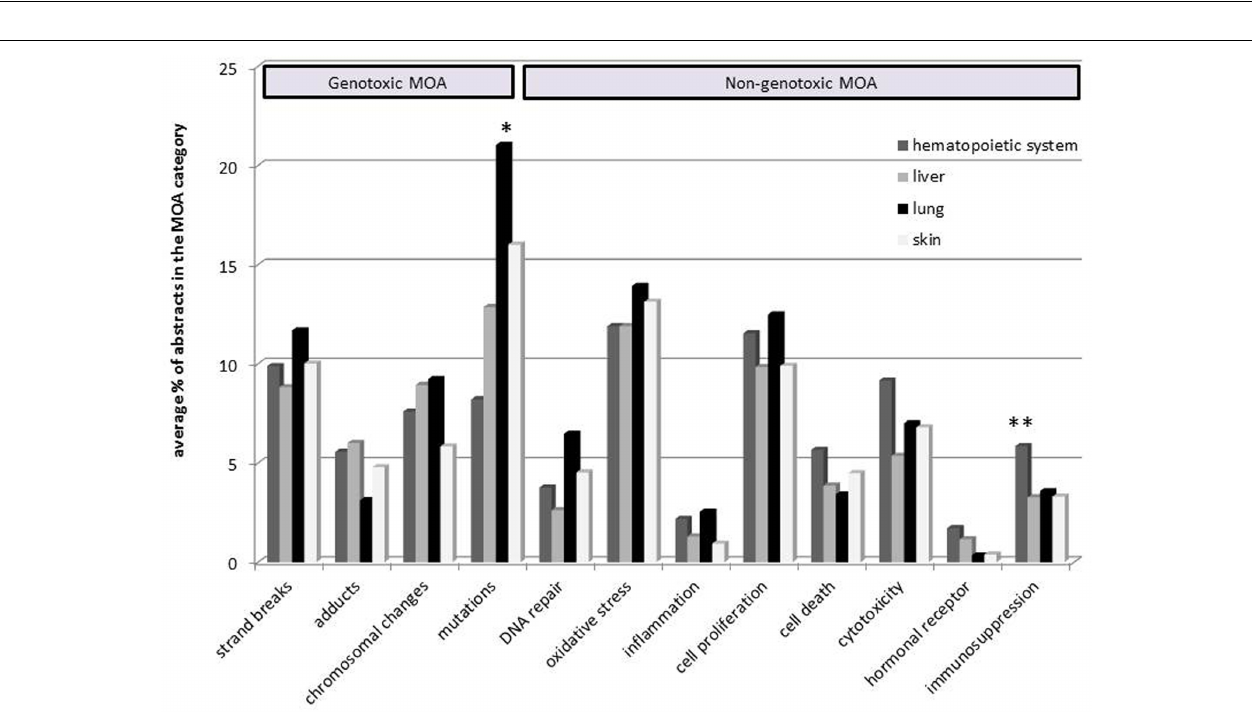
FIGURE 2 | Comparison of literature profiles for four target organs including hematopoietic system, liver, lung, and skin. The average percent of abstracts classified in the MOA taxonomy is shown on the y-axis. Carcinogens were grouped according to their target organ(s). ∗ Significantly different from carcinogens of the hematopoietic system ( p ≤ 0.05), ∗∗ Significantly different compared to liver carcinogens ( p ≤ 0.05).